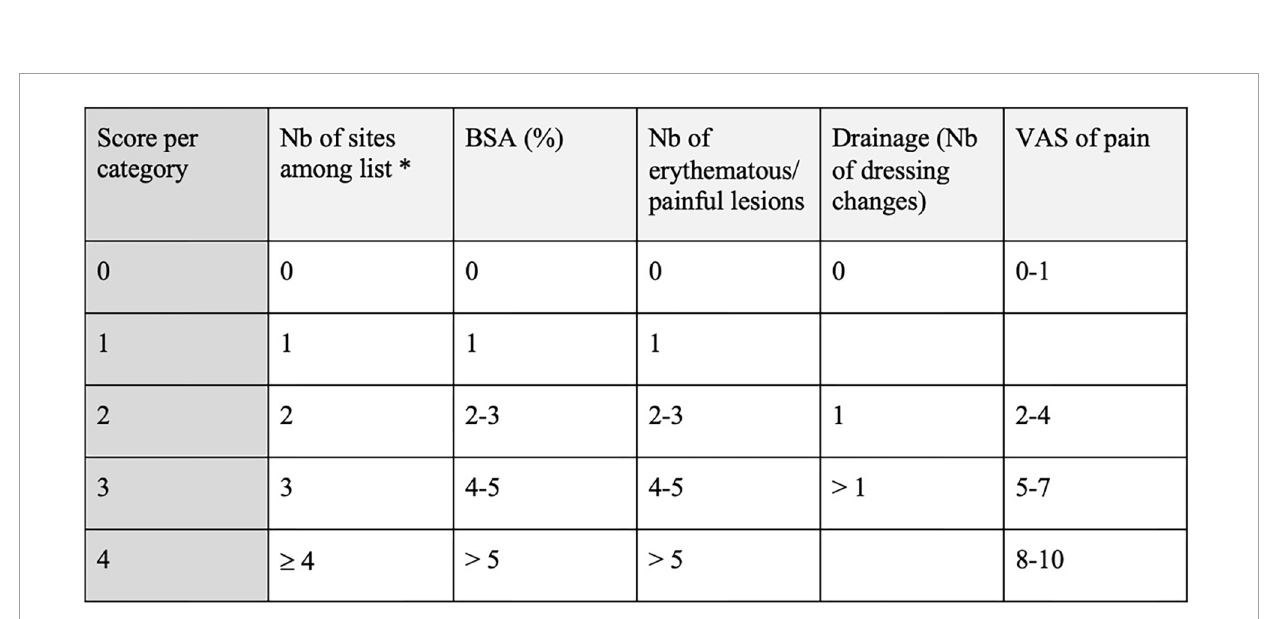
FIGURE4 Hidradenitis Suppurativa severity index (HSSI) (24). ∗ Sites: left armpit, right armpit, left side of chest, right side of chest, left groin, right groin, perianal, and sacral, perineal. Nb, number; BSA, body surface area; VAS, visual analog